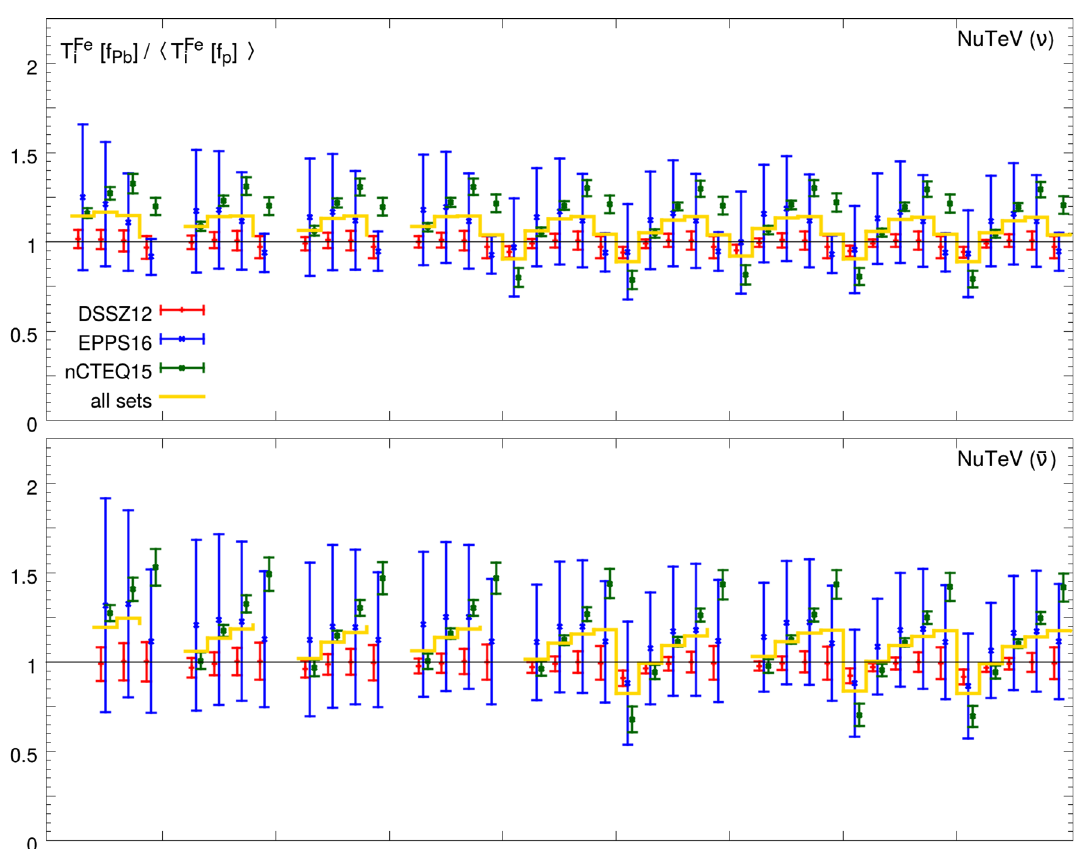
Fig. 5 Same as Fig. 4, but for NuTeV. From left to right, there are nine bins corresponding to three different inelasticities y : 0.334, 0.573, 0.790, and three different neutrino/antineutrino beam energies E ν/ ¯ ν :